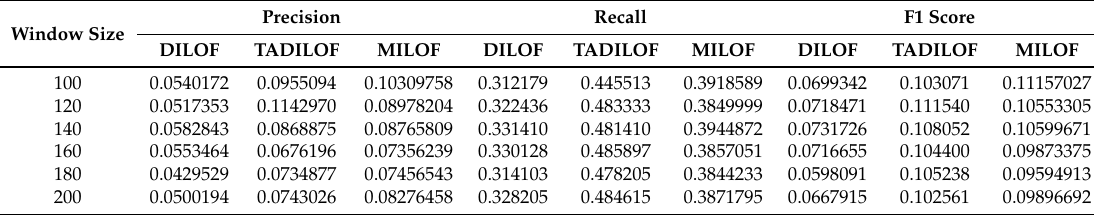
Table 7. Precision, recall, and F1 score on Pendigits dataset.